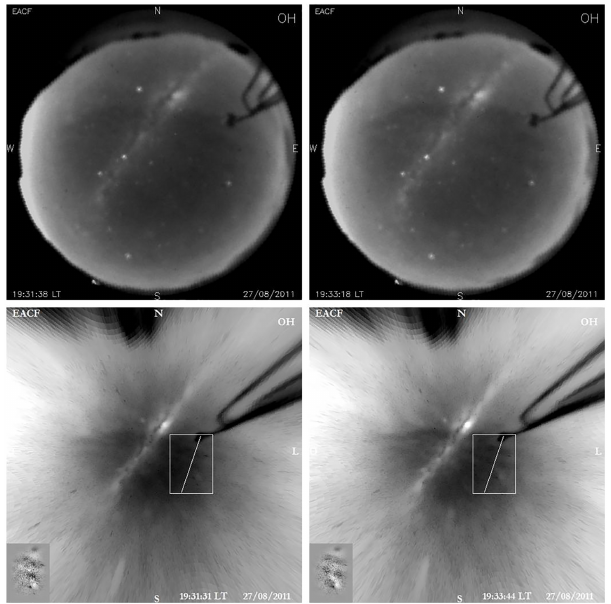
Figure 3. Same as Fig. 1 but for the mesospheric front characterized from 22:30 to 22:34UT on 27 August.